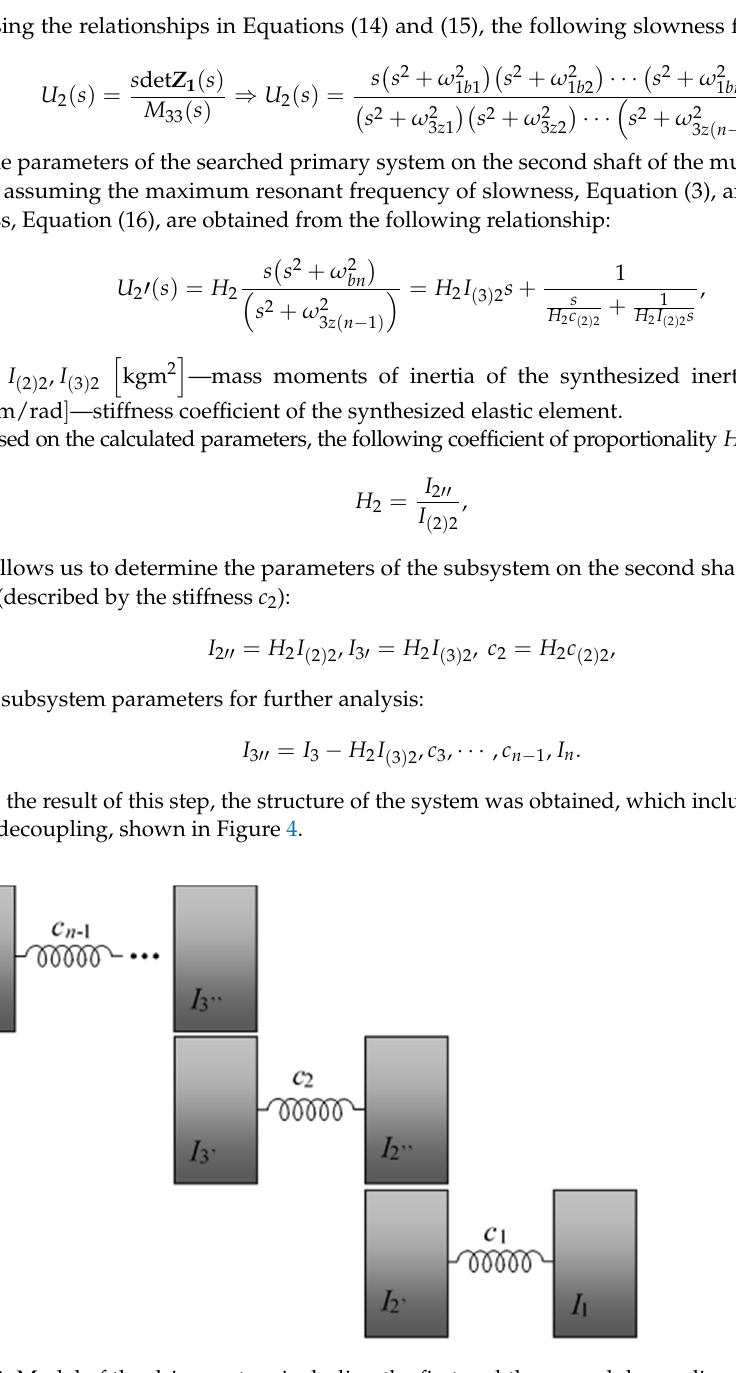
Figure 4. Model of the drive system including the first and the second decoupling. The process describes by the relationships (7–20) is continued until the system is decoupled in relation to the inertial element I n − 1